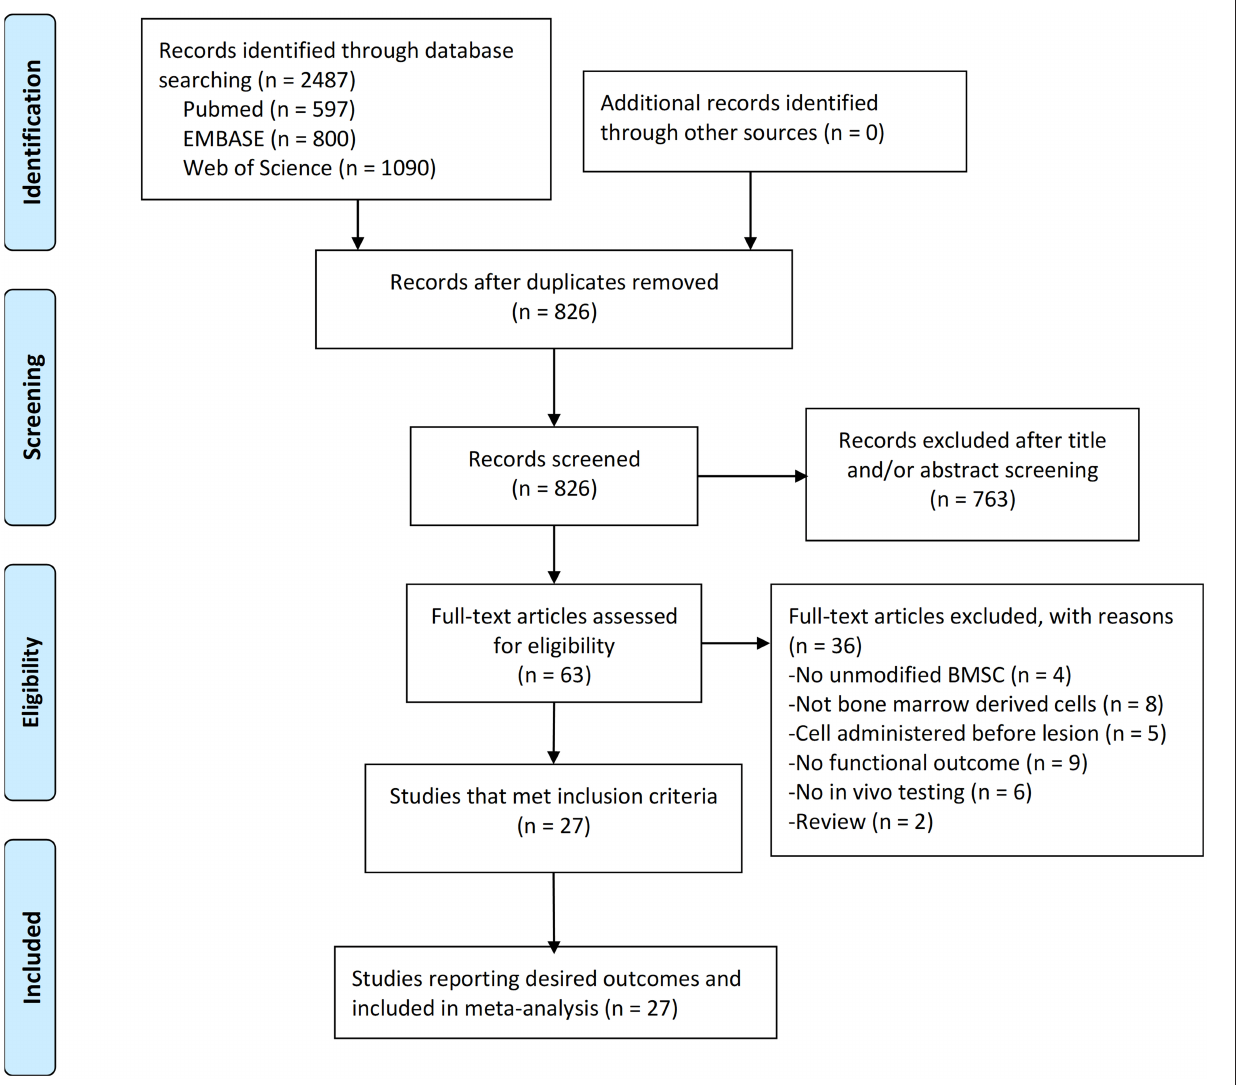
FIGURE 1 | PRISMA flow diagram for review and selection process of studies included in meta-analysis of BMSCs in rodent models of Parkinson’s Disease.